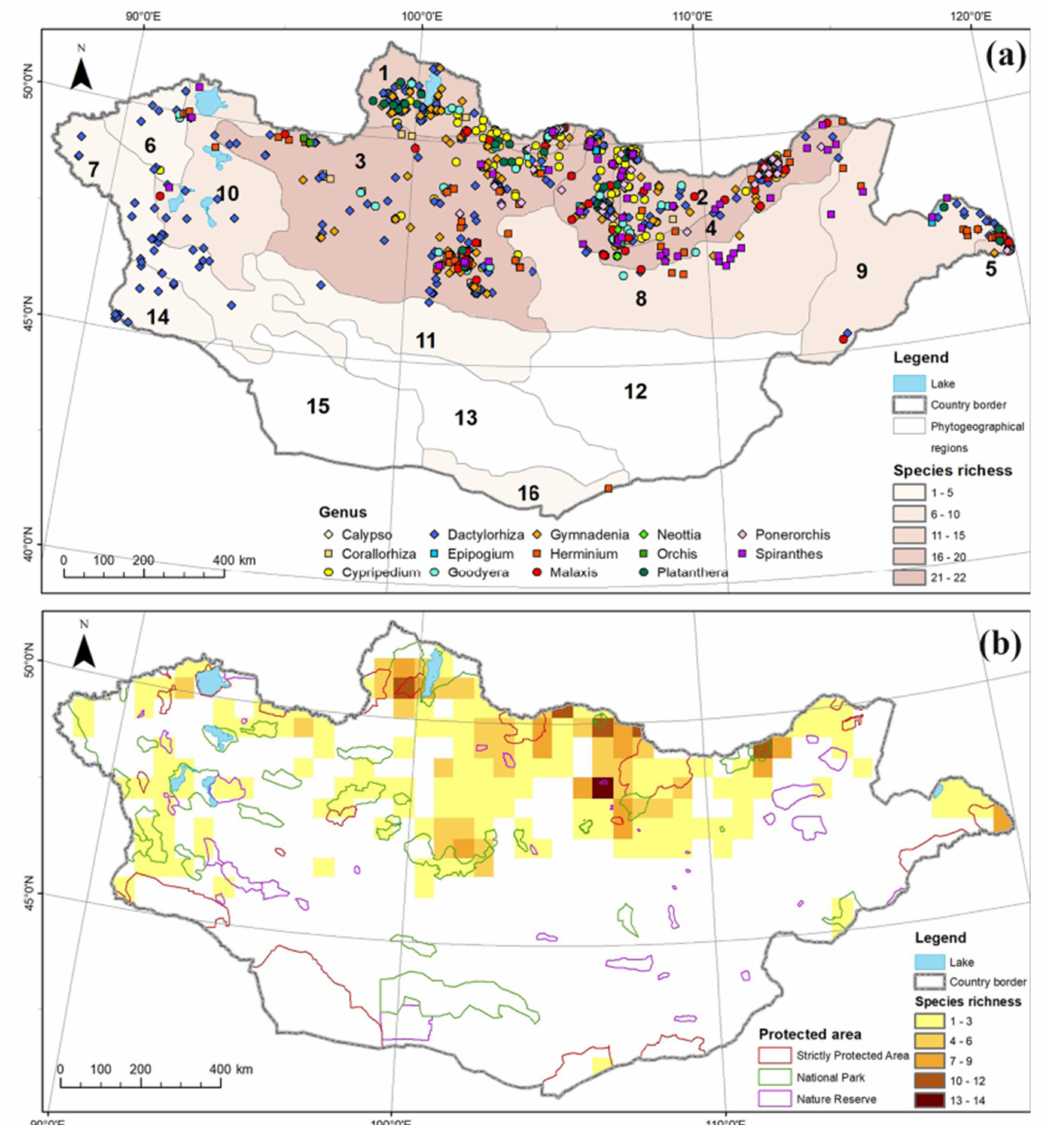
Figure 4. Species distribution pattern of Orchidaceae in Mongolia: ( a ) Species richness based on phytogeographical regions, with distribution points; 1–Khuvsgul, 2–Khentii, 3–Khangai, 4–Mongolian Dauria, 5–Foothills of Great Khingan, 6–Khovd, 7–Mongolian Altai, 8–Middle Khalkh, 9–East Mongolia, 10–Depression of Great Lakes, 11–Valley of Lakes, 12–East Gobi, 13–Gobi Altai, 14–Dzungarian Gobi, 15–Transaltai Gobi, 16–Alashan Gobi. ( b ) Species richness within protected areas based on grid